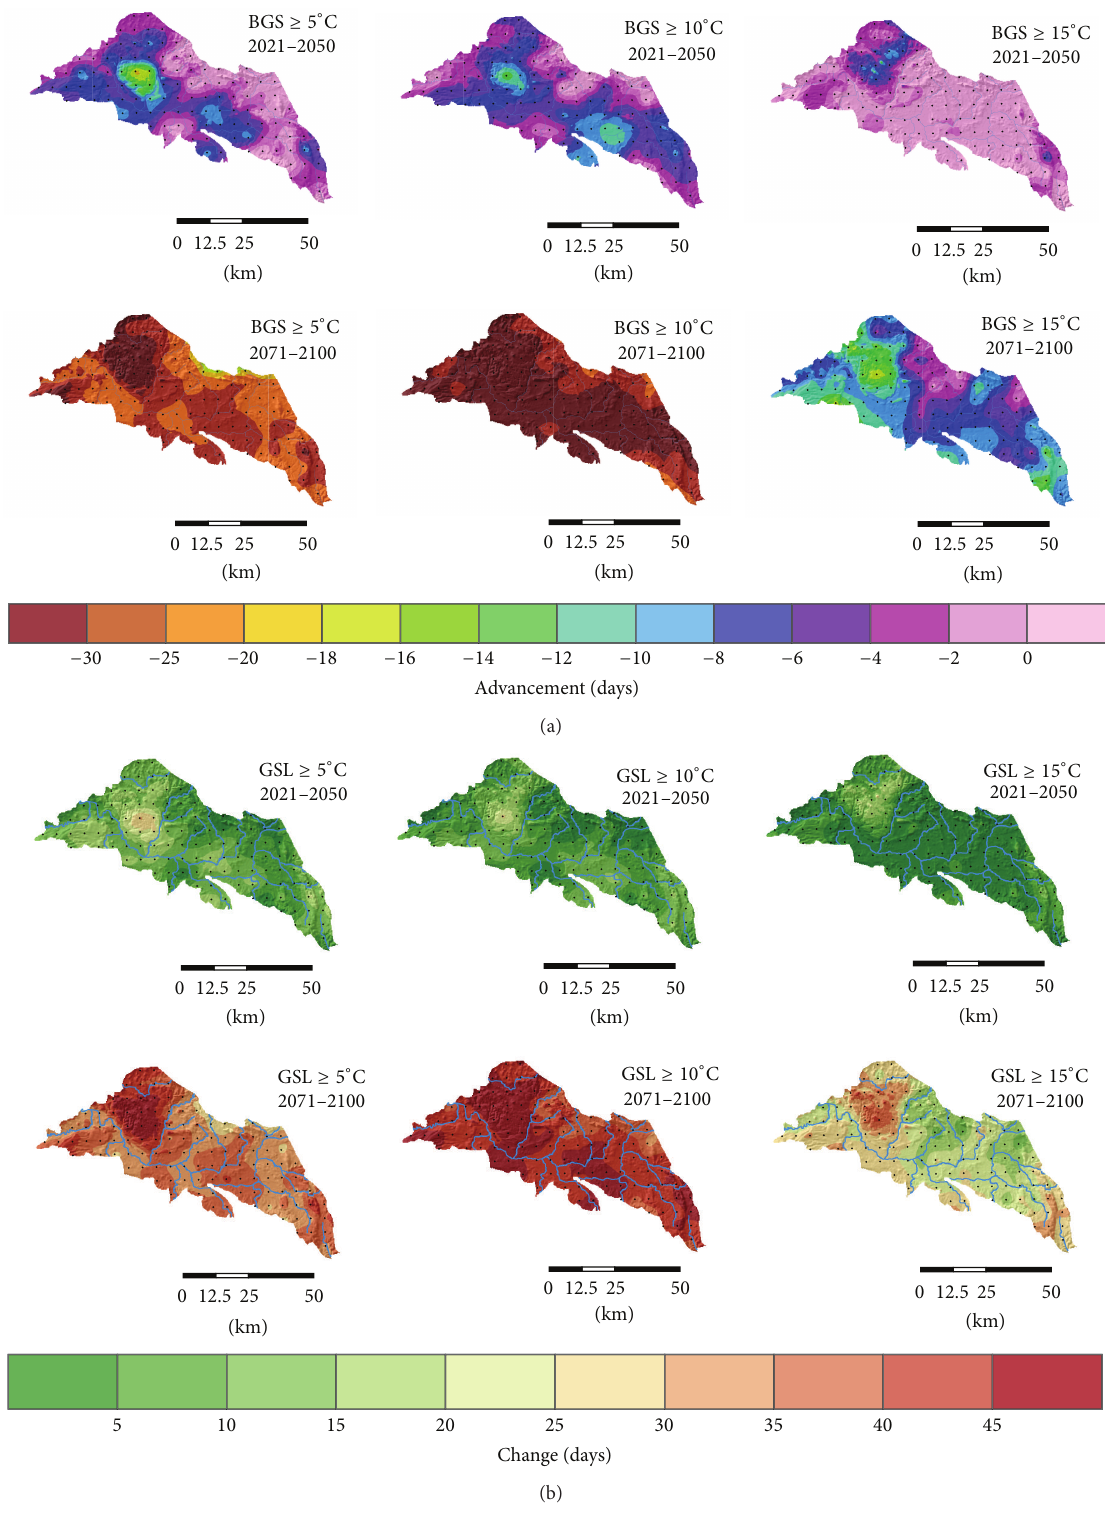
Figure 6: Spatial distribution of projected changes in BGS (a) and GSL (b) for the three threshold temperatures based on ALADIN- Climate/CZ simulation data under the A1B SRES scenario for two future periods, 2021–2050 and 2071–2100, over the Elbe River